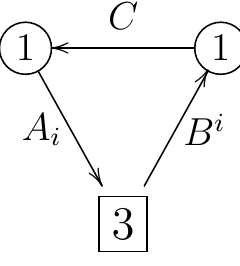
Figure 2: The gauged linear sigma model description of the flag manifold SU ( 3 ) / U ( 1 ) 2 . Each node represents a U ( 1 ) vector multiplet and the square rep- resents the SU ( 3 ) flavor symmetry. A , B i and C denote the chiral superfields in i the fundamental representation of the two gauge groups connected by the corre- sponding arrow. i = 1,2,3 is the flavor SU ( 3 ) index. There is a superpotential term (cid:80) 3 W = A B i C i i = 1